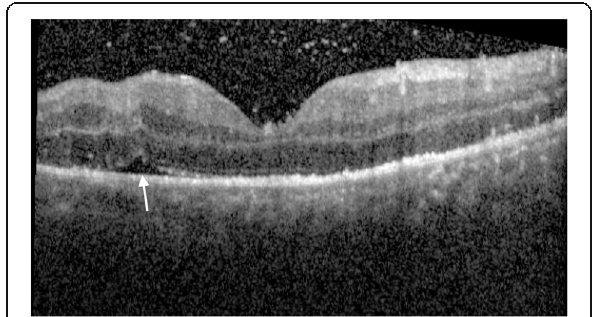
Fig. 7 Spectral domain optical coherence tomography of a secondary syphilis showing the presence of sub retinal fluid (white arrow) associated with thickened neurosensory retina and RPE – choriocapillaris